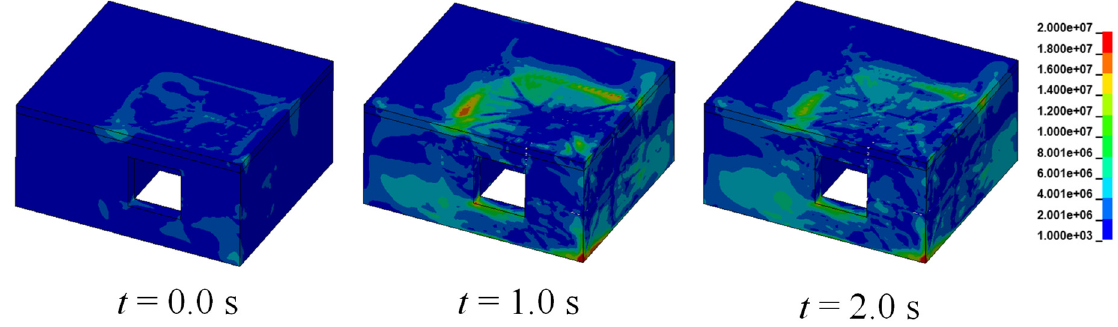
Figure 11. Effective stress (scale in Pa) of trial T7. The first image with time zero corresponds to the stress state when the T7 test load is detonated in the model.